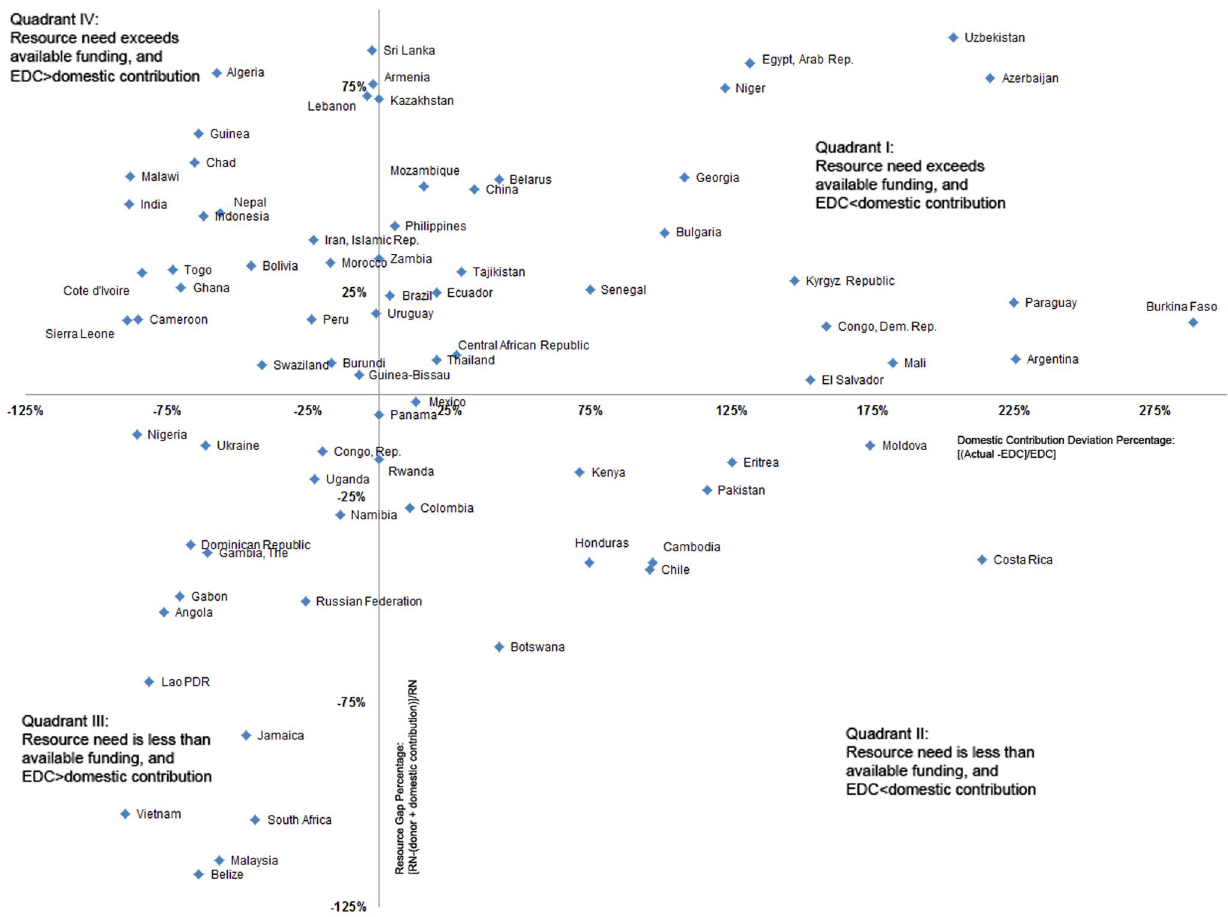
Figure 4. Relative Domestic Contribution Deviation and Funding Gap. The x-axis presents the domestic contribution deviation in relative terms, as percentage of the expected domestic contribution (EDC); while the y-axis shows the relative resource gap as a percentage of resource need. The following outliers fall off the scale: Benin (549%, 13%), Fiji ( 2 11%, 2 220%), Guatemala (74%, 2 130%), Madagascar (2876%, 44%), Mongolia (1739%, 2 314%), Nicaragua (695%, 2 69%) and Romania (325%, 14%). All countries are included in the analyses and in Table 1.